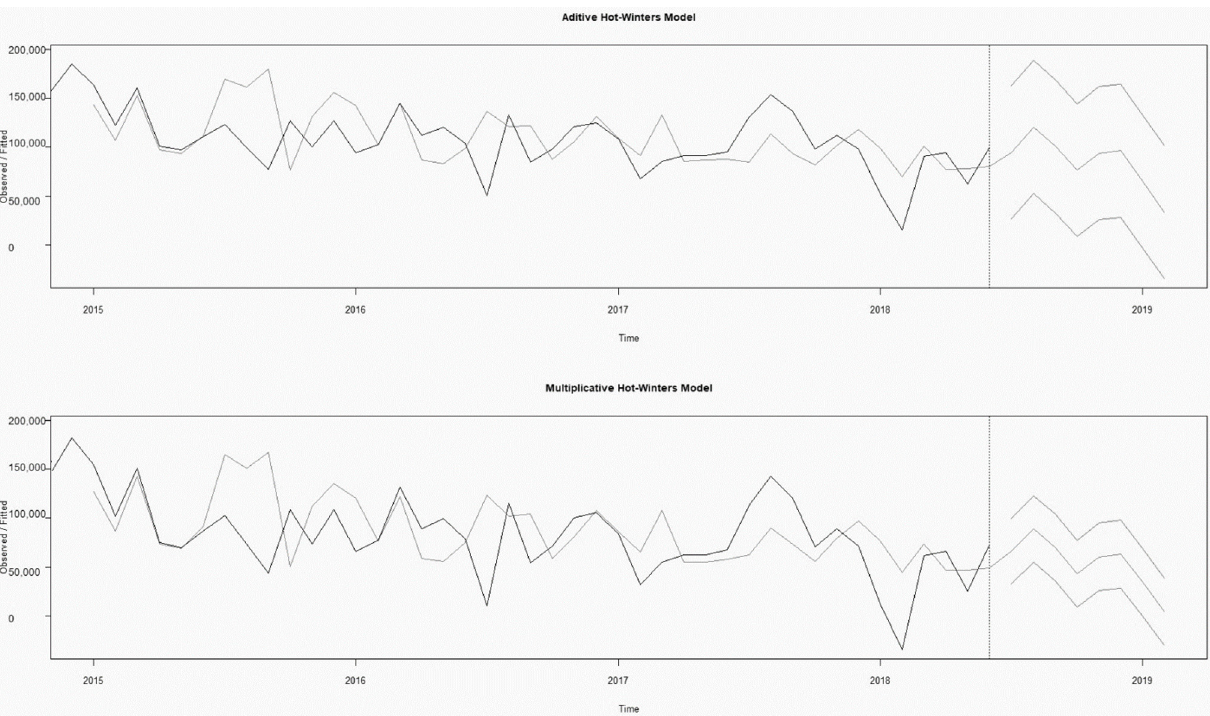
Figure 8. Holt–Winters additive and multiplicative model .